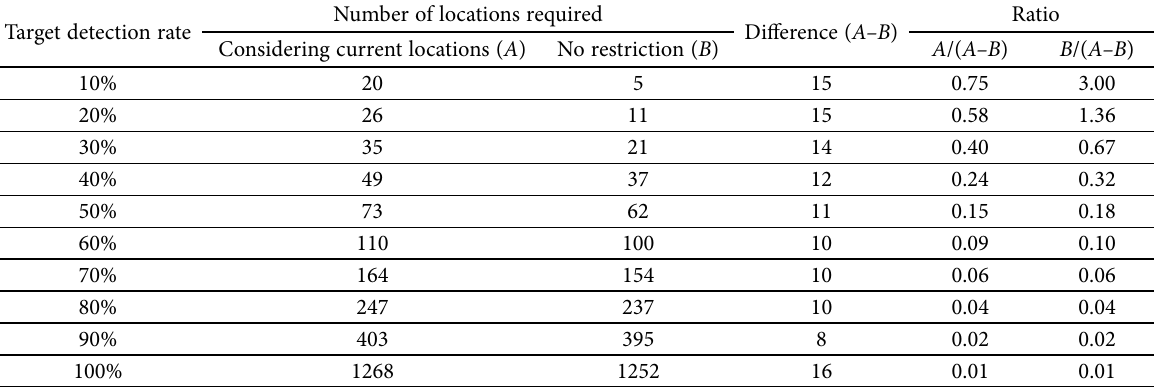
Table 1. Required number of RFID reader locations for achieving the target detection rate Number of locations required Target detection rate